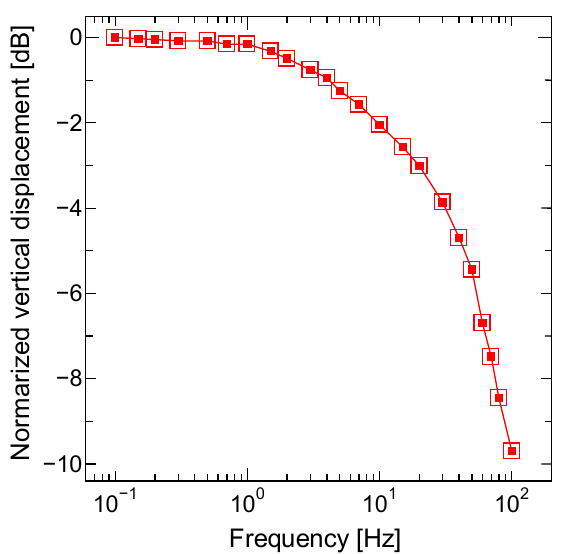
Figure 10. Frequency response of the electrothermal kirigami scanner when applying a sinusoidal wave voltage. The frequency response of the vertical actuation was measured by spot displacement of the beam reflected by the platform.